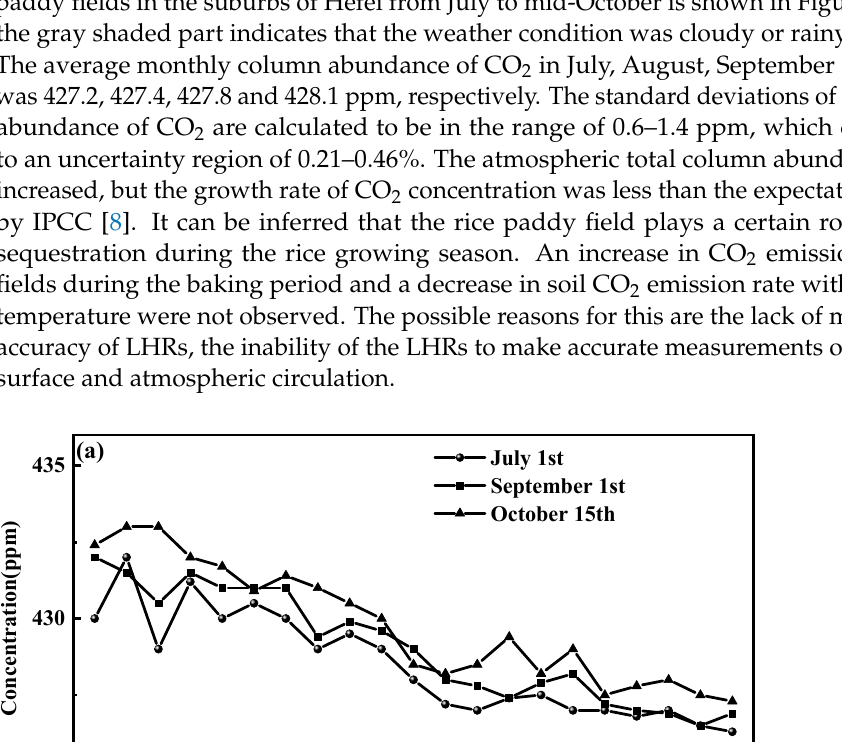
Figure 5. Total column abundance of CO 2 . ( a ) Retrieval results of CO 2 from 10:00 am to 15:00 pm on July 1, September 1 and October 15, 2022; ( b ) time series of the CO 2 retrieval results. Estimations of 95% confidence ranges are indicated. The daily average total column abundance of CO 2 in the atmosphere above the rice paddy fields in the suburbs of Hefei from July to mid-October is shown in Fig. 5b, where the gray shaded part indicates that the weather condition was cloudy or rainy on that day. The average monthly column abundance of CO 2 in July, August, September and October was 427.2, 427.4, 427.8 and 428.1 ppm, respectively. The standard deviations of total col- umn abundance of CO 2 are calculated to be in the range of 0.6–1.4 ppm, which corre- sponds to an uncertainty region of 0.21–0.46%. The atmospheric total column abundance of CO 2 increased, but the growth rate of CO 2 concentration was less than the expectation reported by IPCC [8]. It can be inferred that the rice paddy field plays a certain role in carbon sequestration during the rice growing season. An increase in CO 2 emission from rice fields during the baking period and a decrease in soil CO 2 emission rate with decreas- ing temperature were not observed. The possible reasons for this are the lack of